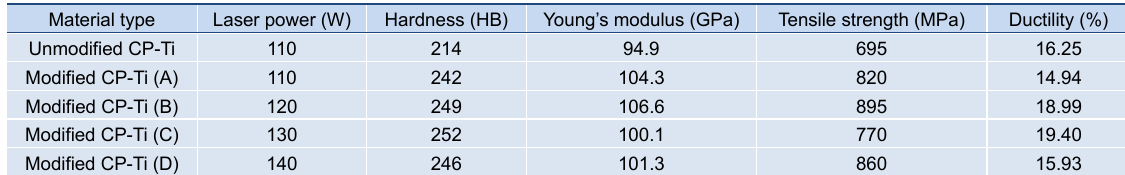
Table 2 | Mechanical properties of the as-printed CP-Ti modified powder and the unmodified, spherical Ti powder . Different laser powers were used for printing the modified Ti powder, denoted as